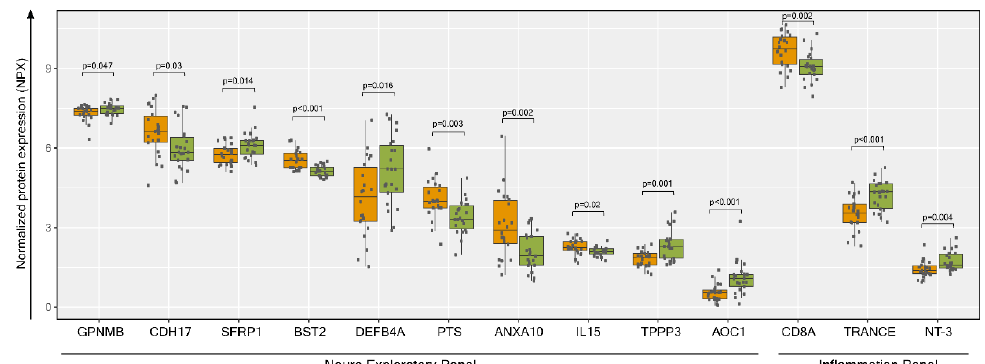
Figure 9. Plasma proteomics profiling and protein metabolite interactions. Normalized protein expression (NPX) visualization of significantly enriched proteins ( p < 0.05) from Welch’s two-sample t -test between HC (green) and PLHIV (orange) groups. GPNMB: Transmembrane glycoprotein NMB (GPNMB), CDH17: cadherin-17, SFRP1: secreted frizzled-related protein 1, BST2: bone marrow